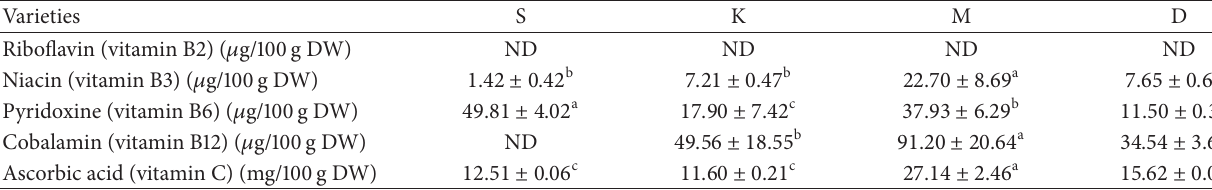
Table 2: Water-soluble vitamin contents of okra pods.